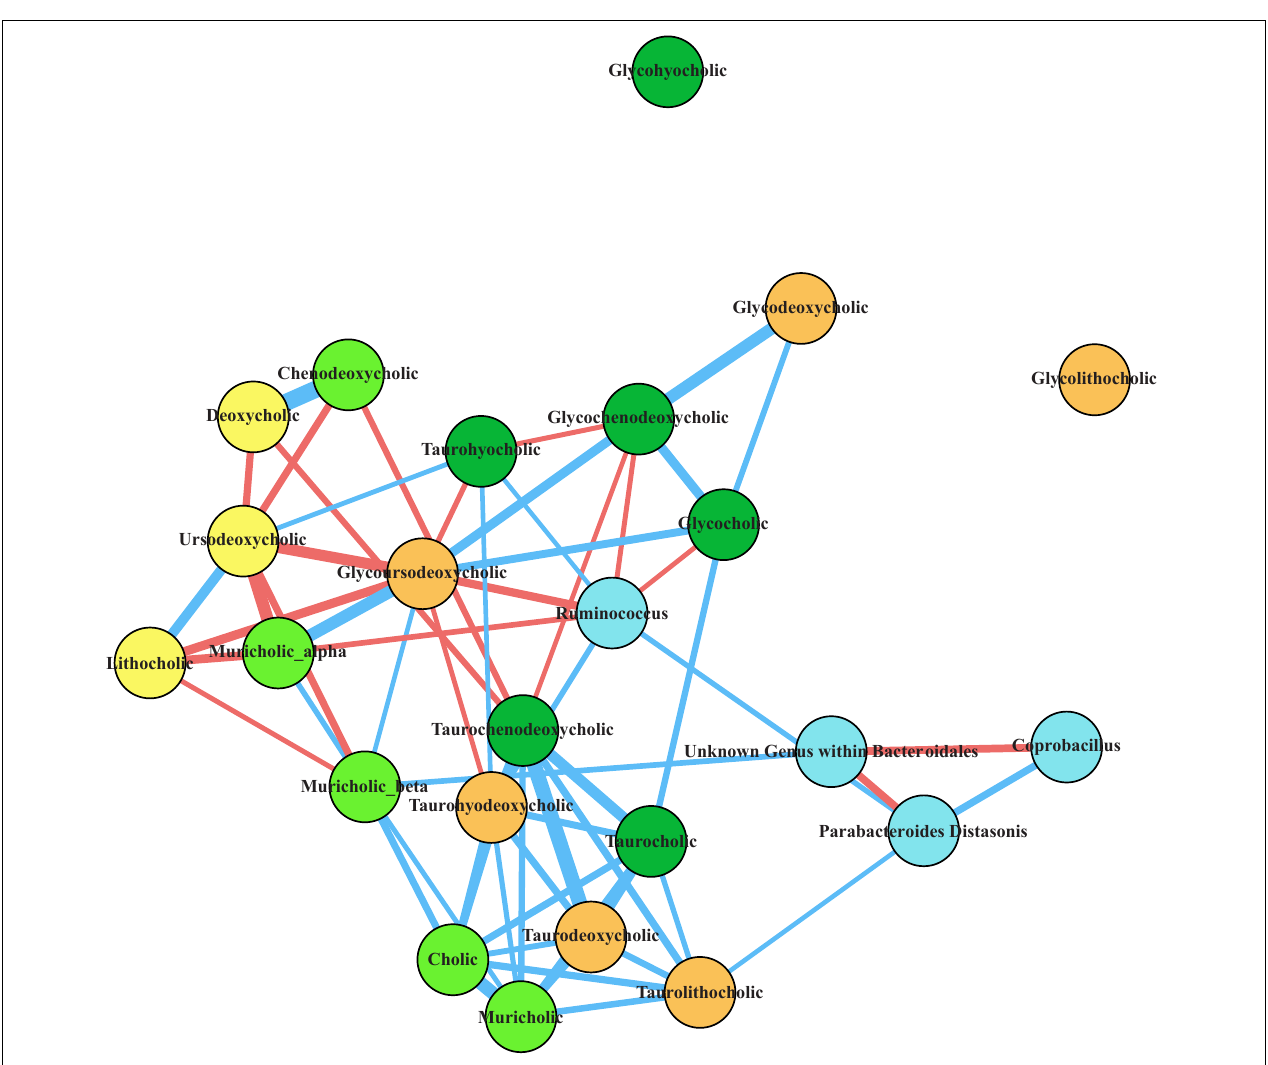
FIGURE 7 | Correlation network of taxa of interest and fecal bile acids at T3. Twenty bile acids were identified from untargeted LC/MS/MS mass spectrometry of fecal samples collected at the time of baseline sleep (T3). Pairwise Spearman’s rank order correlations of bile acids and relative abundances of fecal bacteria of interest were performed across all animals, and correlations that were significant after correcting for multiple comparisons ( q < 0.05) are depicted in the network diagram above. Nodes are colored as follows: light blue, bacteria; light green, primary bile acids; dark green, conjugated primary bile acids; yellow, secondary bile acids; orange, conjugated secondary bile acids. The thickness of the line between nodes correlates to the magnitude of Spearman’s rho , blue lines indicate positive rho values, and red lines indicate negative rho